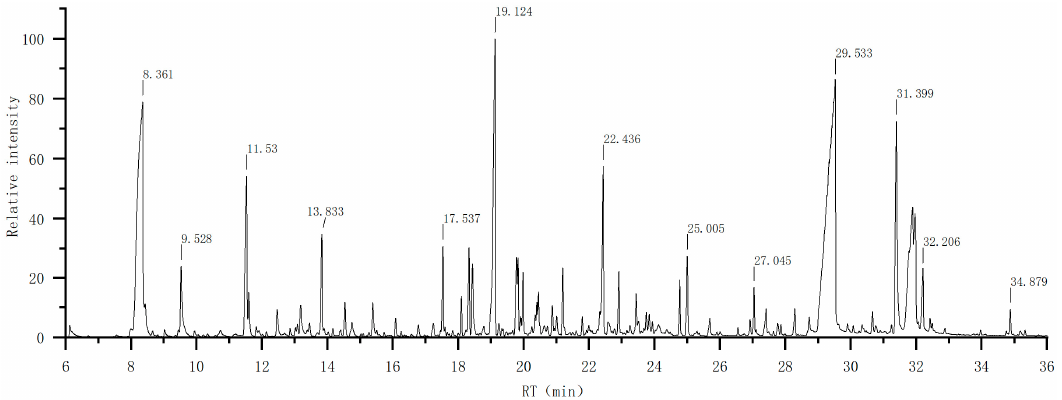
Figure 2. Ion chromatogram of the essential oils of T. triquetrum (L.) Ohashi.